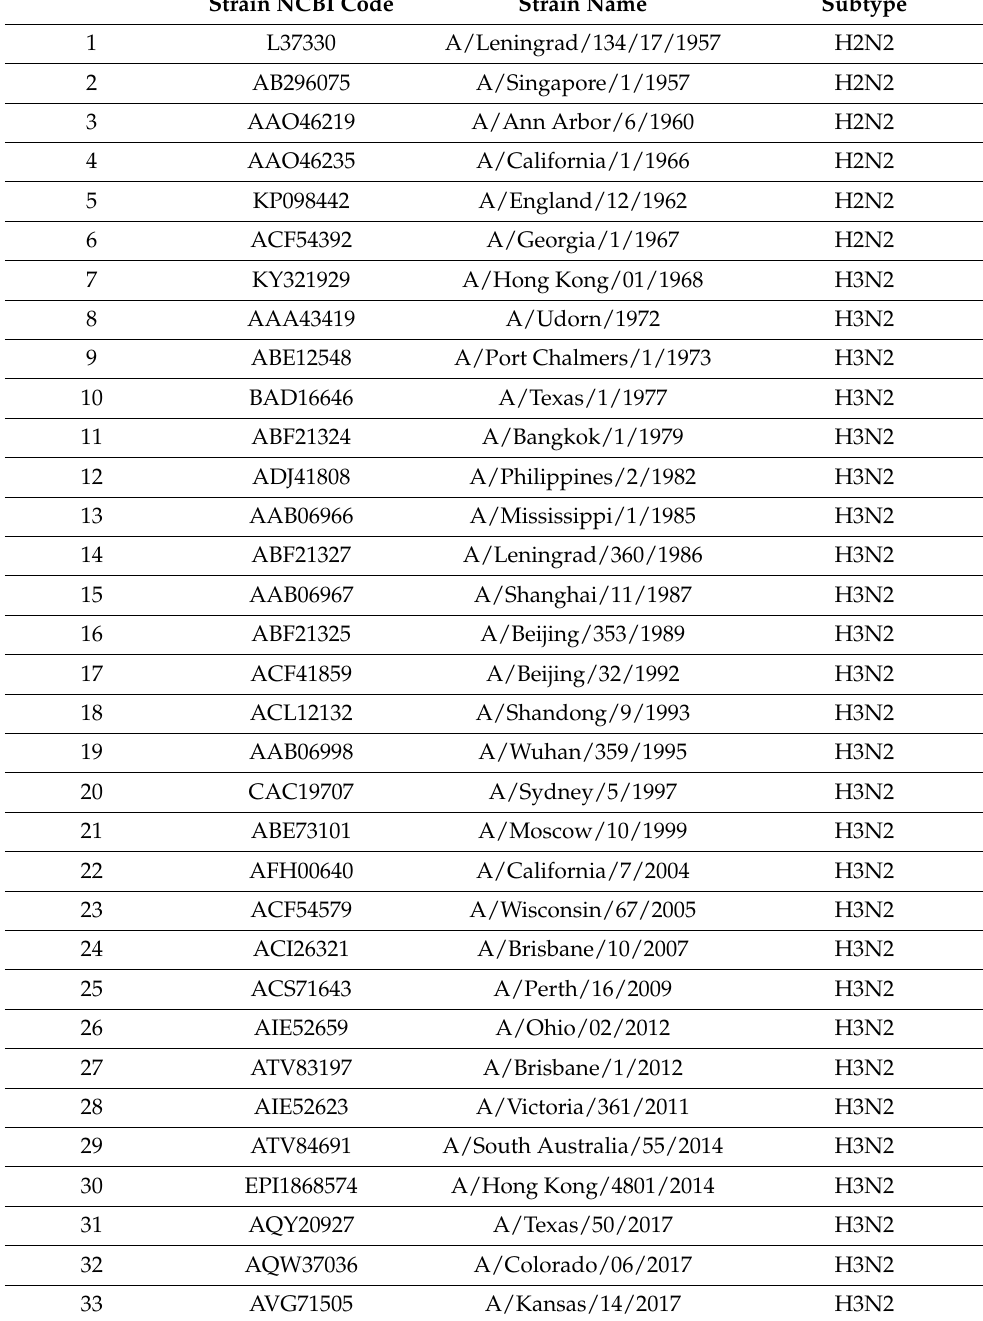
Table 4. Influenza virus strains used for NA phylogenetic